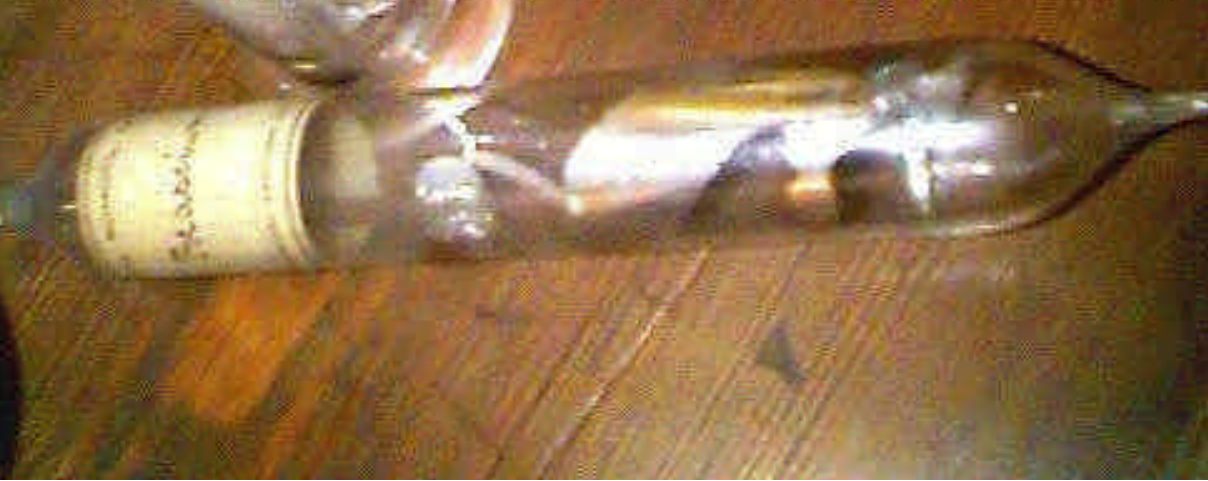
Figure 1. Sample of 19th century